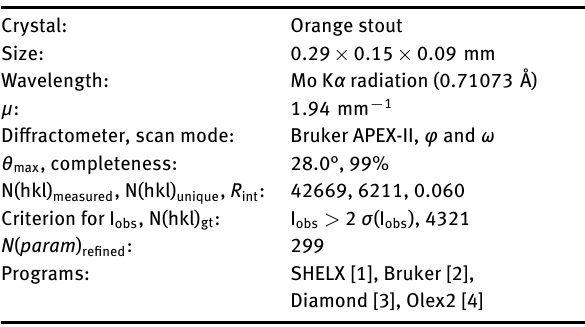
Table 1: Data collection and handling.